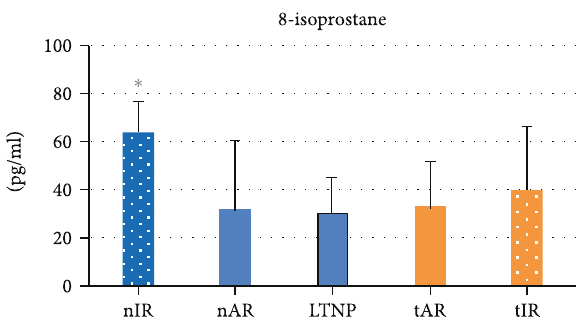
Figure 4: Plasma levels of 8-isoprostane of 92 people living with HIV/AIDS, according to the fi ve composed groups. This marker is upregulated in nIR. Statistical tests: gamma distribution. ∗ p < 0 05 , di ff erence among all the other